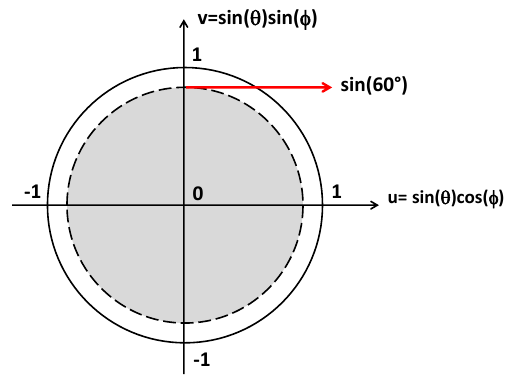
Figure 2. Circular sector cell in the u – v plane within which the HAPS antenna array has to steer the main beam to serve the 5G users.